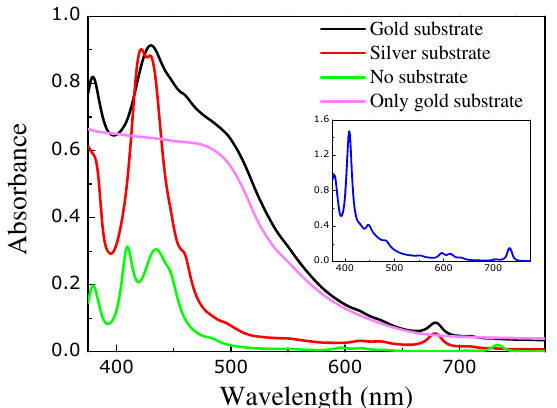
Figure 3. Absorbance of normally incident light on the array of nanocubes described in Figure 2 with or without a metallic substrate. The substrate is 50 nm thick and is either gold or silver. The inset shows the absorption cross section for light incident normally on a single